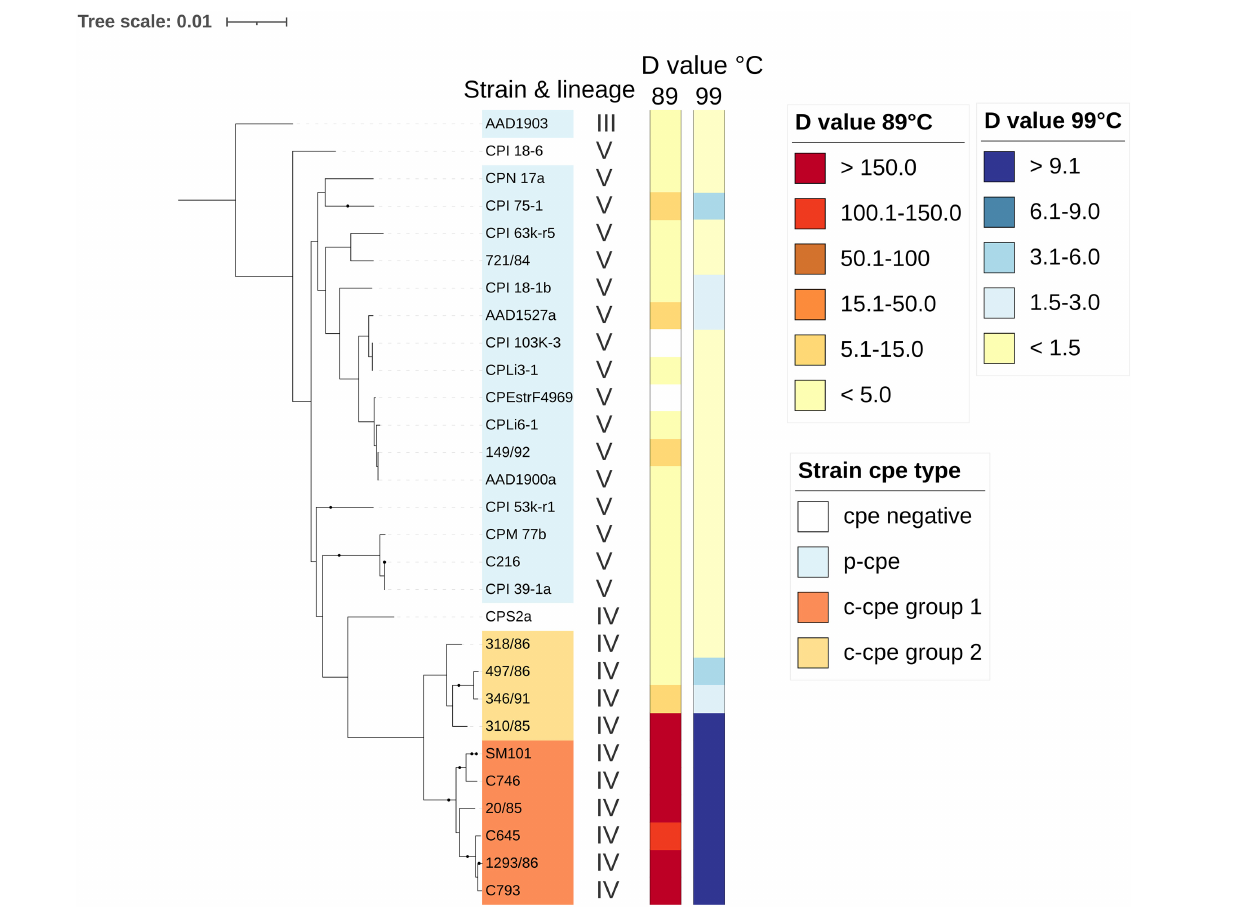
FIGURE 4 | Spore heat-resistance results of Clostridium perfringens strains as D 89 ◦ C and D 99 ◦ C values. Strains from lineages III, V, and IV were assayed. Groups of chromosomal cpe -carrying strains produced heat-sensitive spores (c-cpe group 2) and were phylogenetically distinct from other c-cpe strains (c-cpe group 1). Measured D values (min) for C. perfringens strains are shown here against a maximum-likelihood phylogenetic tree of 29 C. perfringens strains (27 strains sequenced and heat resistance tested in this study and two reference strains: SM101 and CPE str. F4969). For SM101 and CPE str. F4969, D values were cited from previous publications (Li and McClane, 2008; Sarker et al., 2000). Strain 310/85 was an outlier in c-cpe group 2 producing distinctly heat resistant spores (D 89 ◦ C value 204 min).